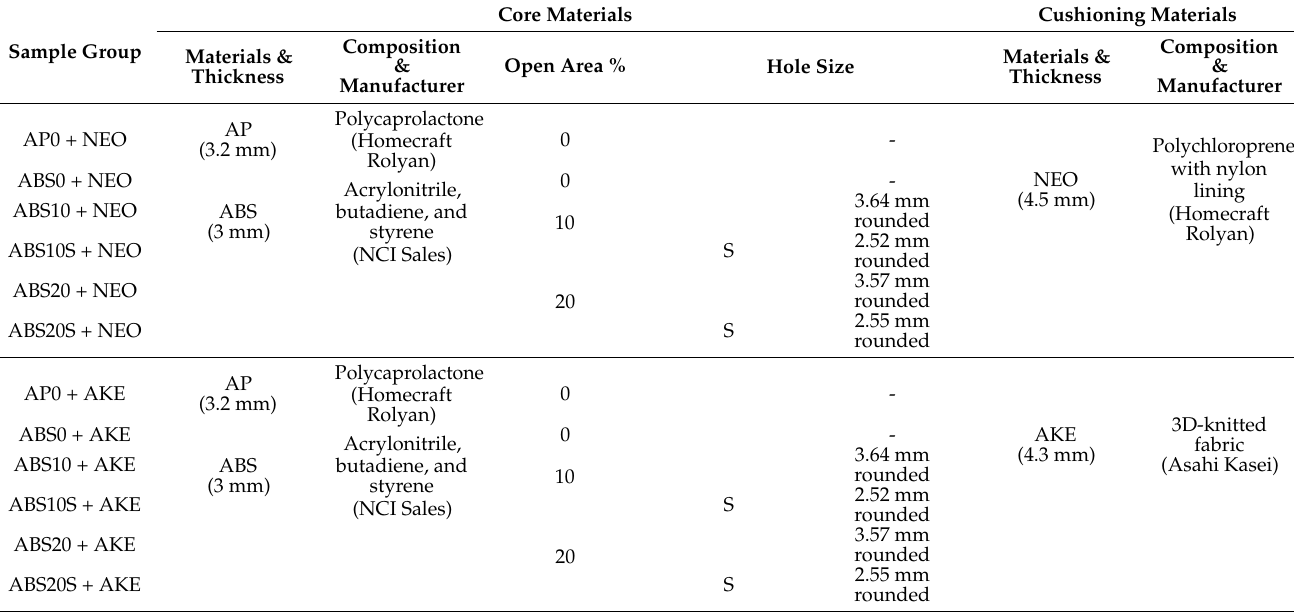
Table 2. Groups of examined materials in this